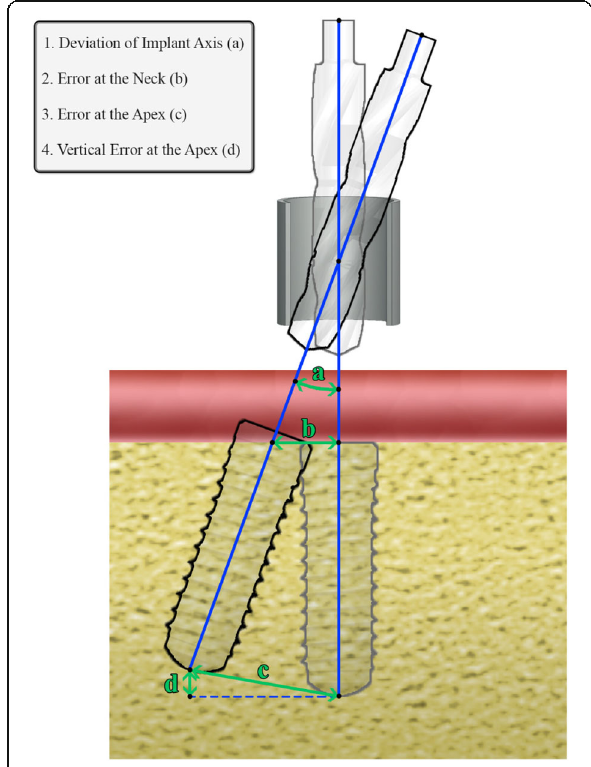
Fig. 2 The various errors in implant